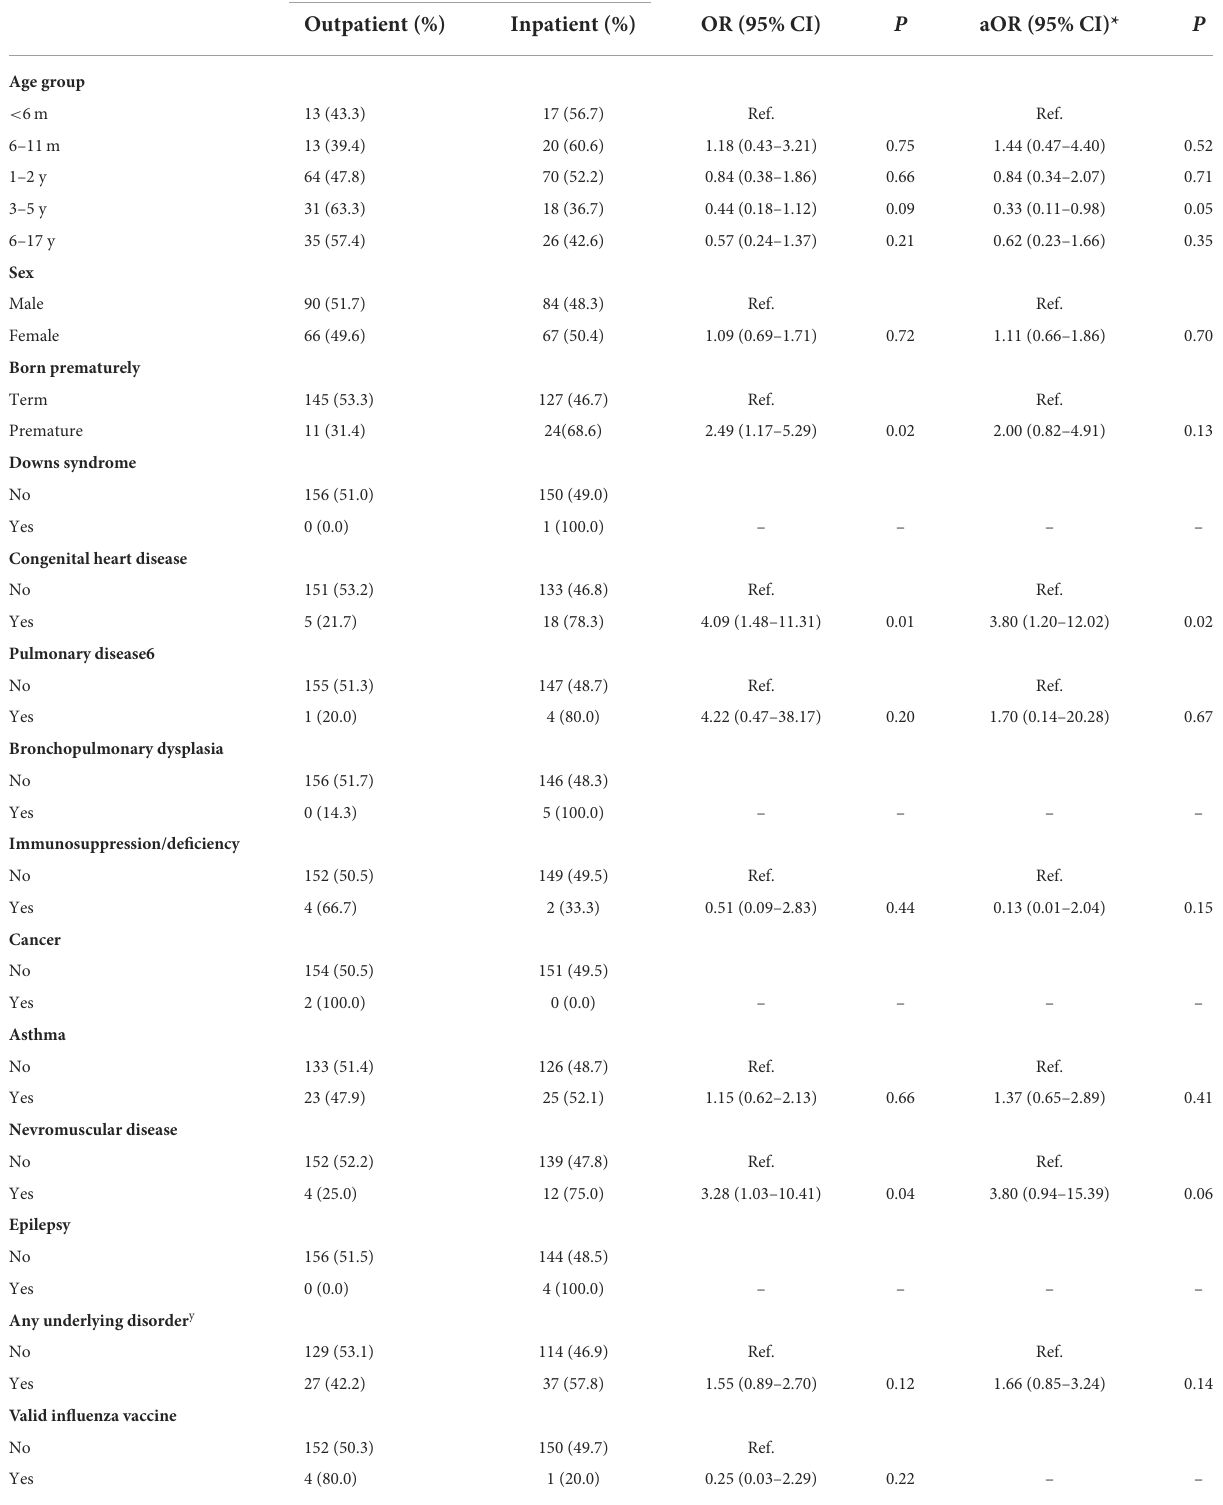
TABLE 4 Logistic regression comparing influenza positive outpatient and inpatient